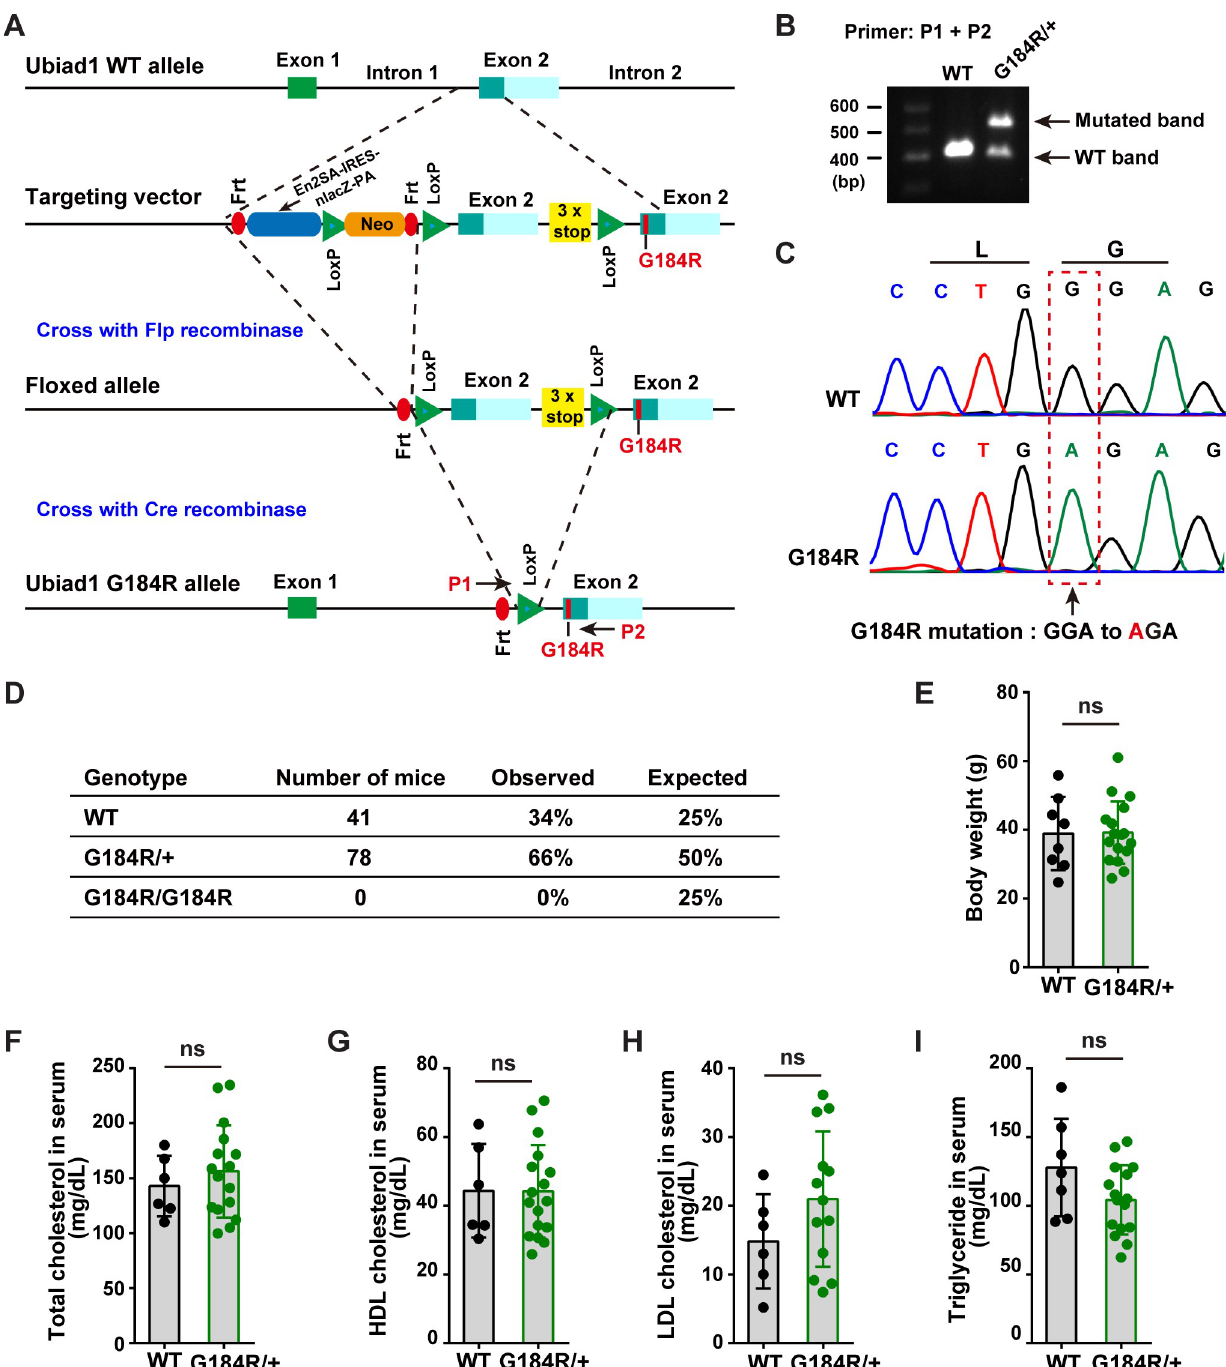
Fig 5. Generation and characterization of Ubiad1 G184R/+ knock-in mice. (A) Strategy of construction Ubiad1 G184R/+ knock-in mice. Knockout first conditional ready strategy was adopted to establish Ubiad1 G184R/+ knock-in mice. A gene-trap cassette was inserted between intron 1 and exon 2 of Ubaid1 allele after homologous recombination, resulting in Ubiad1 knockout mice. Crossing with Flp recombinase-expressing strain leads to the excision of Frt- flanked cassette and the expression of WT Ubiad1 protein, as there were three stop code sequence following the inserted exon 2. Subsequently, crossing with EIIA-Cre recombinase leads to the removal of Loxp-flanked cassette and the expression of mutated G184R Ubiad1 protein. Primer 1 (P1) and primer 2 (P2) were designed to identified genotypes. Frt, Flp recognition target; Loxp, Cre recognition region; En2 SA, En2 intron 2/exon 3 splice acceptor region; IRES, internal ribosome-entry site; LacZ, β -galactosidase; PA, PolyA; Neo, neomycin. (B) Genotyping of Ubiad1 +/+ (WT) and Ubiad1 G184R/+ (G184R/+) mice. Genomic DNA was extracted from tail biopsies, and PCR products were amplified with P1 and P2 primers to determine the genotyping of mice. WT and mutated fragments were separated with 1% agarose gel. (C) Sequencing maps of WT and mutated band. The WT and mutated band in (B) are excised